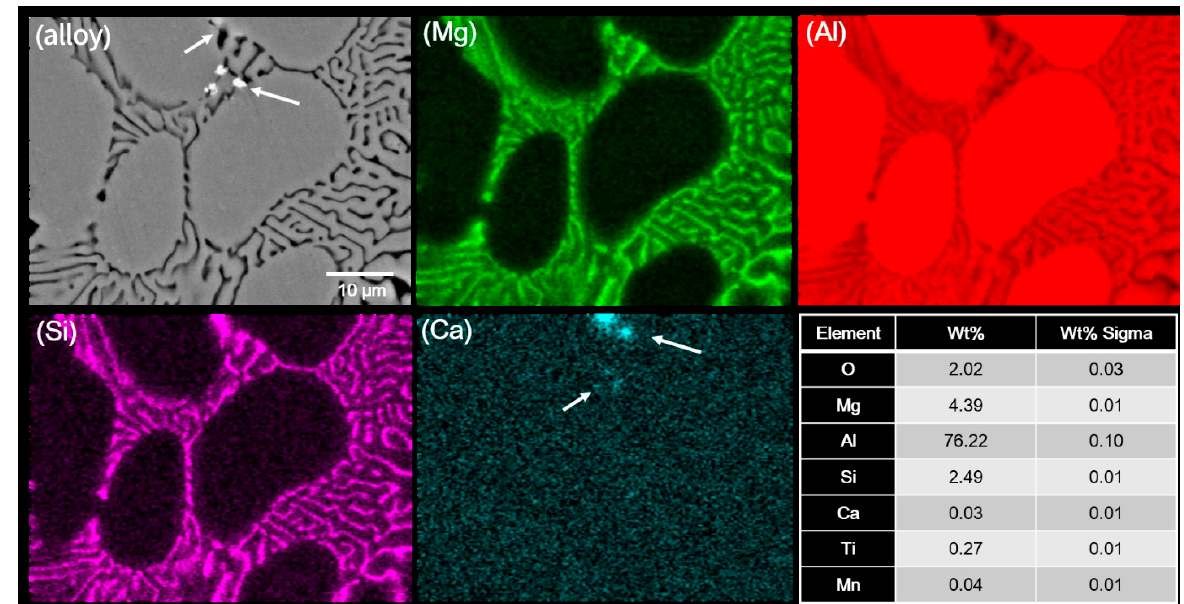
Figure 3. SEM–EDS mapping analysis of E1 alloy revealing the composition distribution of various elements. (alloy) SEM micrograph of E1 alloy, while the table shows the composition of various elements detected in mapping analysis. Here, white arrows are pointing at Ca-rich phases.